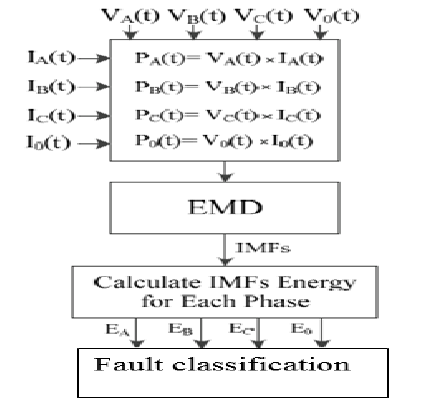
Figure 2. Fault detection using